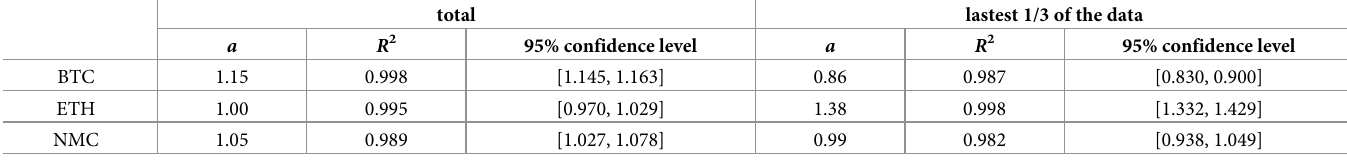
Table 2. Fitting parameters of the power law.